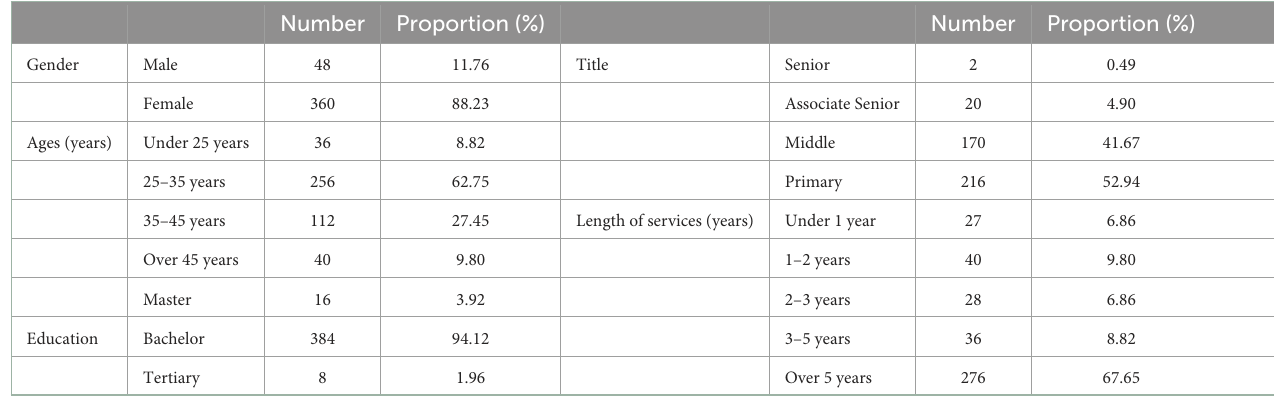
TABLE 2 Statistical participants’ demographic